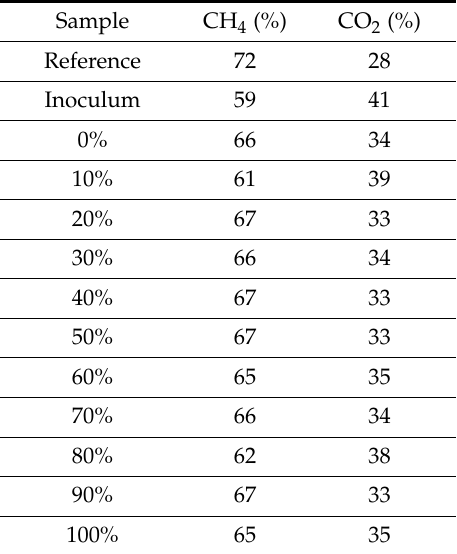
Table 5. The biogas composition at different mixing